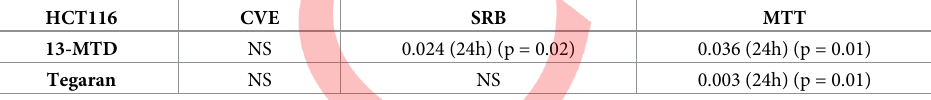
Table 6. HCT116 cell line IC50 concentrations for 13-MTD and Tegaran according to CVE, SRB and MTT assay (NS- No significant).